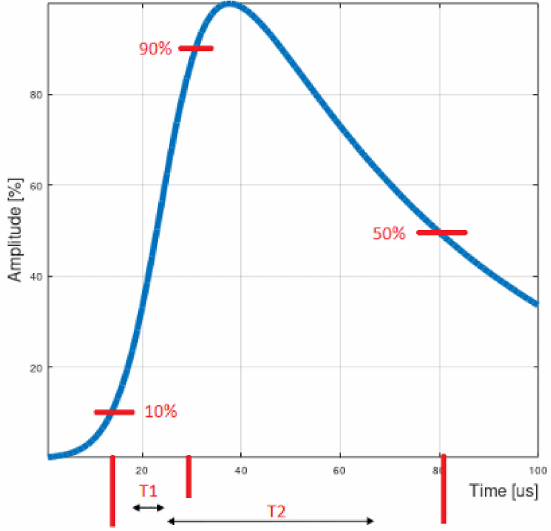
Figure 2. Pulse of the WF4 type, representing the impact of lightning (DO-160 standard for avionics testing)